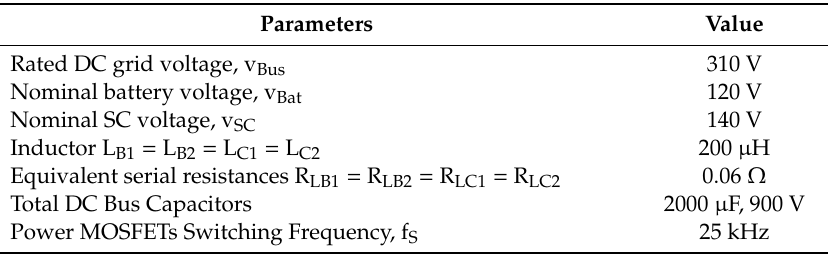
Figure 6. Hybrid test bench platform at the laboratory RERC − KMUTNB. Table 1. Converter parameters.